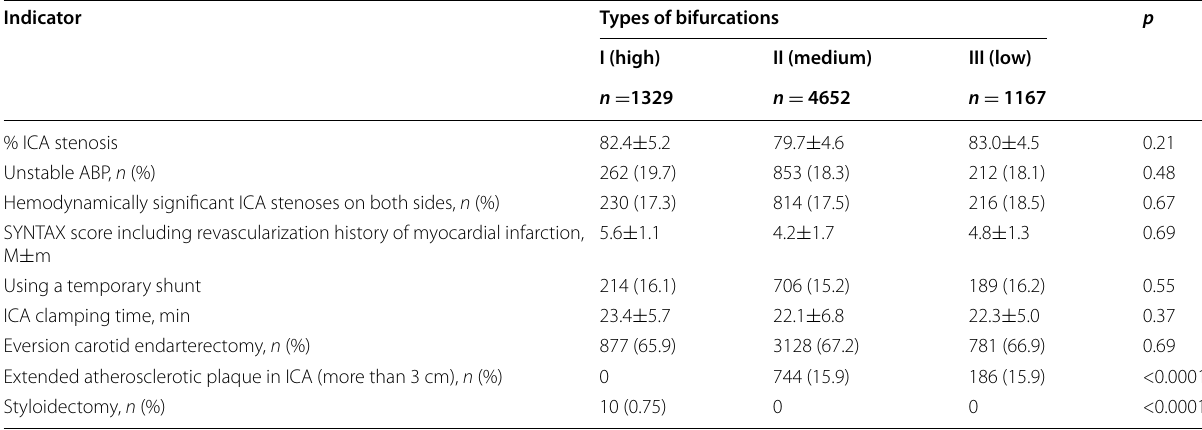
Table 2 Angiographic and perioperative